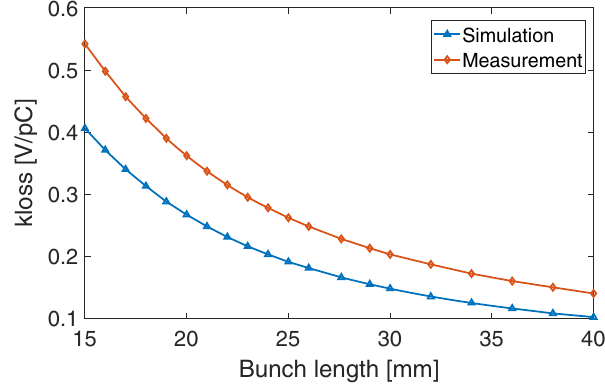
FIG. 13. The loss factor as a function of rms bunch length obtained from coaxial wire measurement and wakefield simulations.